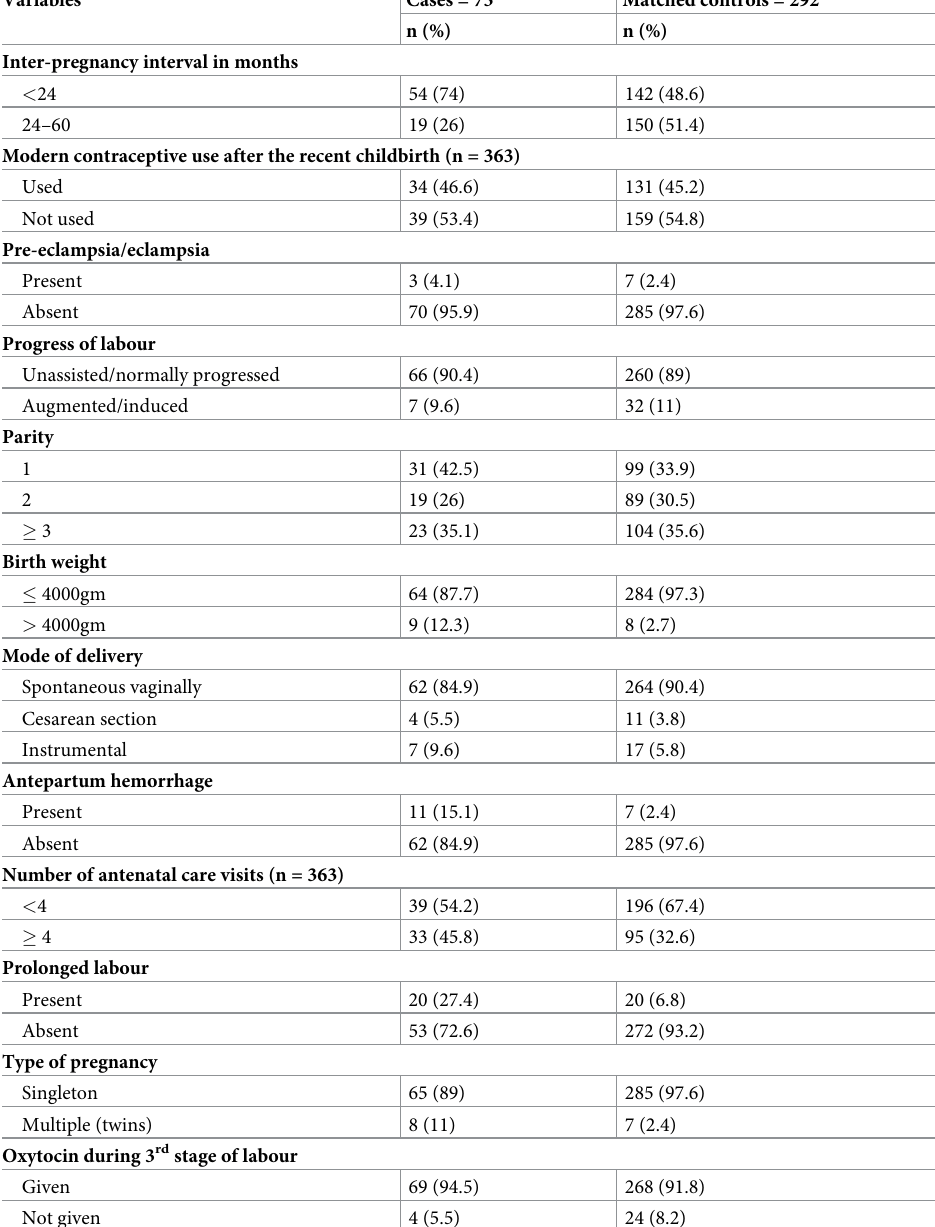
Table 2. Reproductive and maternal health service-related characteristics of the participants in urban South Ethi- opia, July 2019-September 2020. Variables Cases = 73 Matched controls = 292 n (%) n (%) Inter-pregnancy interval in months < 24 54 (74) 142 (48.6) 24–60 19 (26) 150 (51.4) Modern contraceptive use after the recent childbirth (n = 363) Used 34 (46.6) 131 (45.2) Not used 39 (53.4) 159